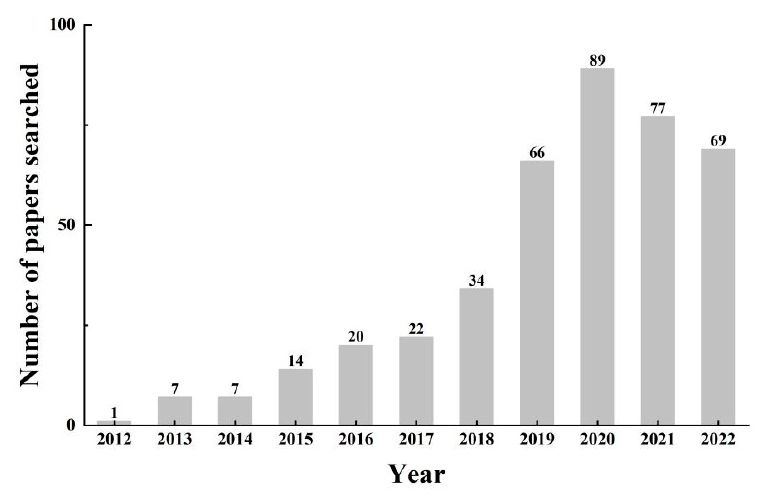
Figure 1. Research statistics on application of the data-driven method in BECP.